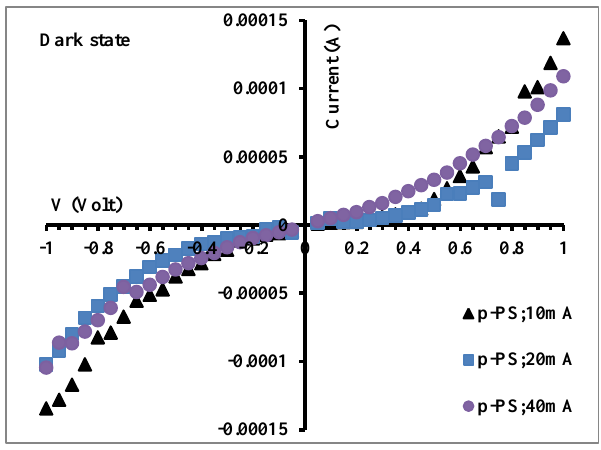
Fig. 5: I-V characteristics in the dark for